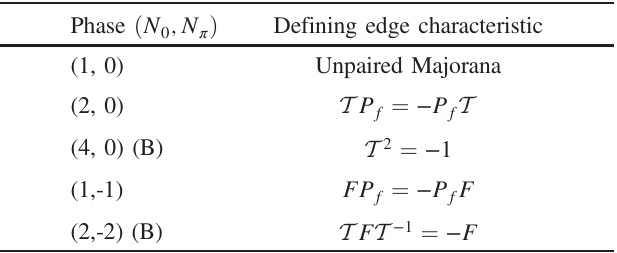
TABLE I. Time-reversal symmetric 1D fermion FSPTs . — The classification of 1D interacting fermionic Floquet SPTs with time reversal (class BDI) has a Z 8 × Z 4 group structure. Topological phases are labeled by the number of Majorana zero- and π - quasienergy modes, ð N 0 ; N π Þ , present in the absence of inter- actions. The projective edge algebra that defines these phases is shown in the right column. The phases labeled (B) are topologi- cally equivalent to bosonic FSPT phases.